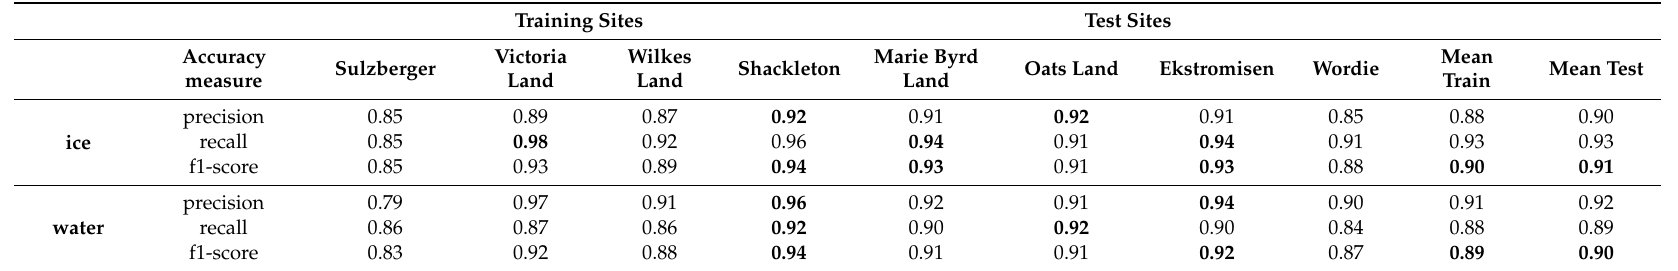
Table 1. Classification performance for all training and test sites (June 2018). High / low values are indicated in